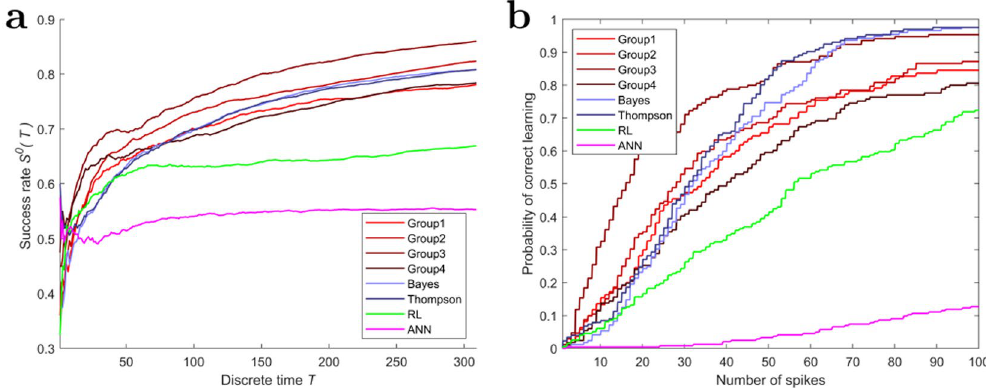
Figure 6. Time-dependent success rates and learning duration. a Success rate as a function of time for the four human groups and the four computational models. ( b ) Proportion of batches with learning durations averaged across all decision-makers for all groups.